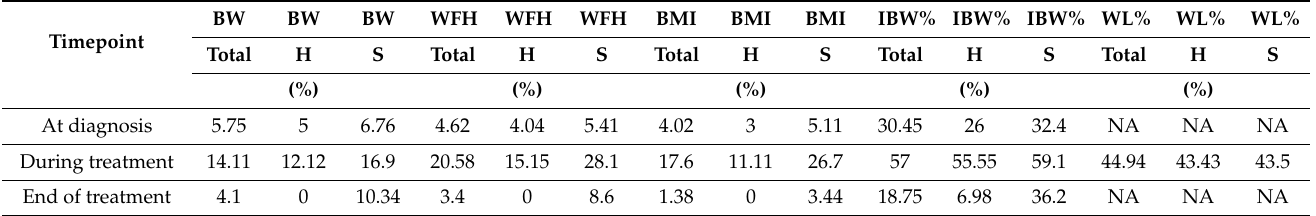
Table 4. Rate of incidence of undernutrition based on different